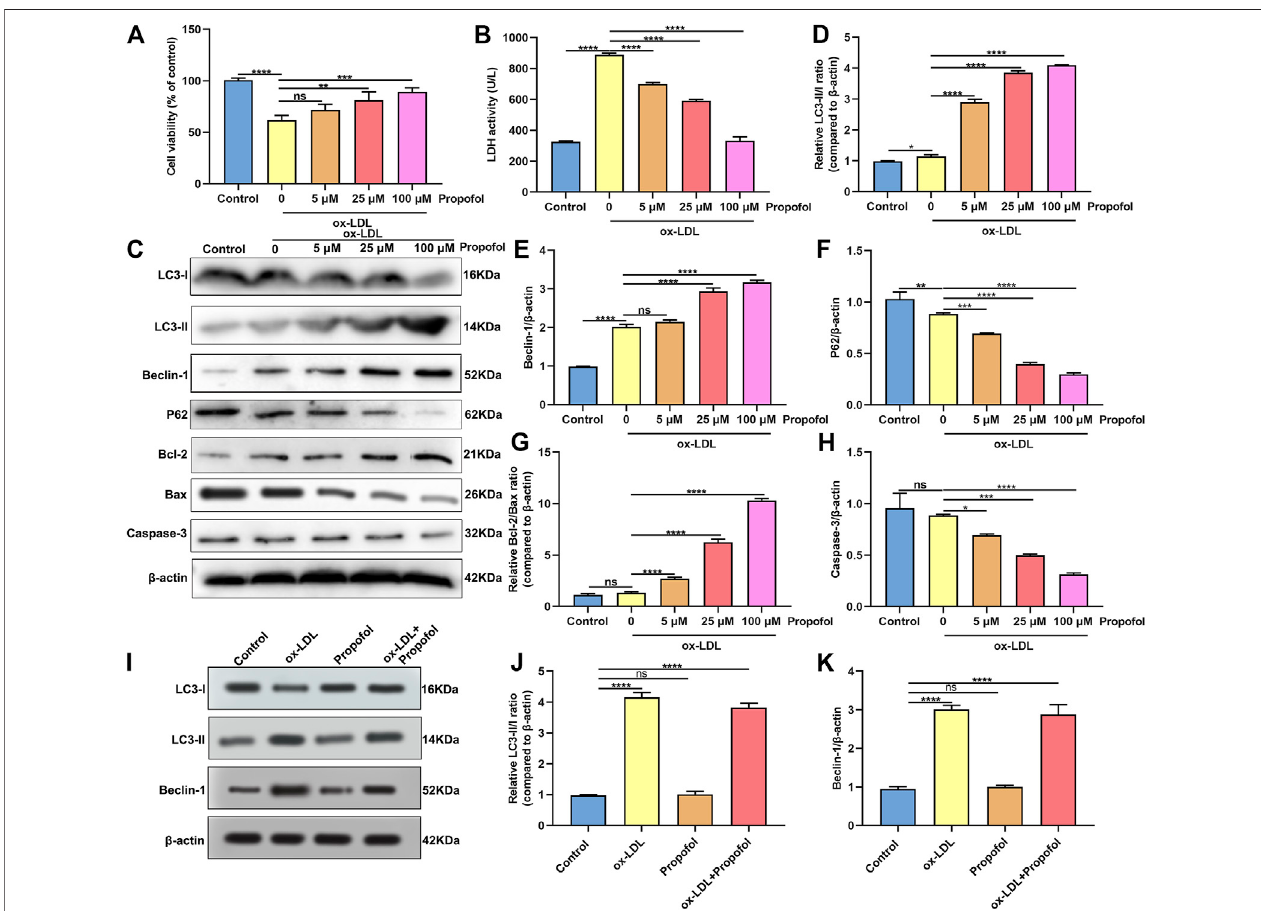
FIGURE2| PropofolenhancesautophagyinHUVECsunderexposuretoox-LDL. (A) Cellviabilitywasutilizedfortheevaluationoftheviabilityof100 ° μ g/mlox-LDL- induced HUVECs following treatment with 0, 5, 25 and 100 ° μ M Propofol. (B) LDH release levels were determined in 100 ° μ g/mL ox-LDL-exposed HUVECs following disposal with different concentrations of Propofol. (C) Representative of western blots for LC3-I, LC3-II, Beclin-1, P62, Bcl-2, Bax and Caspase-3. (D) LC3-II/I ratio, (E) Beclin-1, (F) P62, (G) Bcl-2/Bax and (H) Caspase-3 expression levels were quanti fi ed in 100 ° μ M Propofol-treated HUVECs under exposure to 100 ° μ g/ml ox-LDL. (I-K) Western blot for (J) LC3-II/I ratio and (K) Beclin-1 expression in HUVECs treated with 100 ° μ g/ml ox-LDL and / or 100 ° μ M Propofol. Ns: no statistical signi fi cance; * p < 0.05; ** p < 0.01; *** p < 0.001 and **** p < 0.0001.